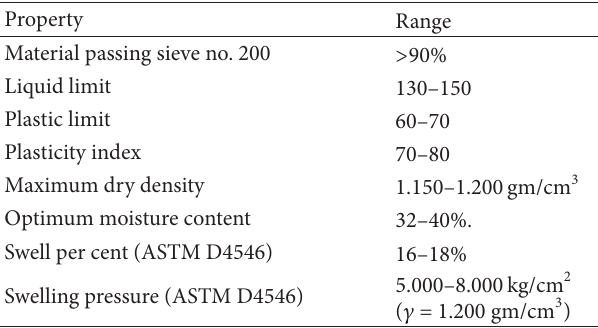
T 1: Physical properties of Al-Qatif